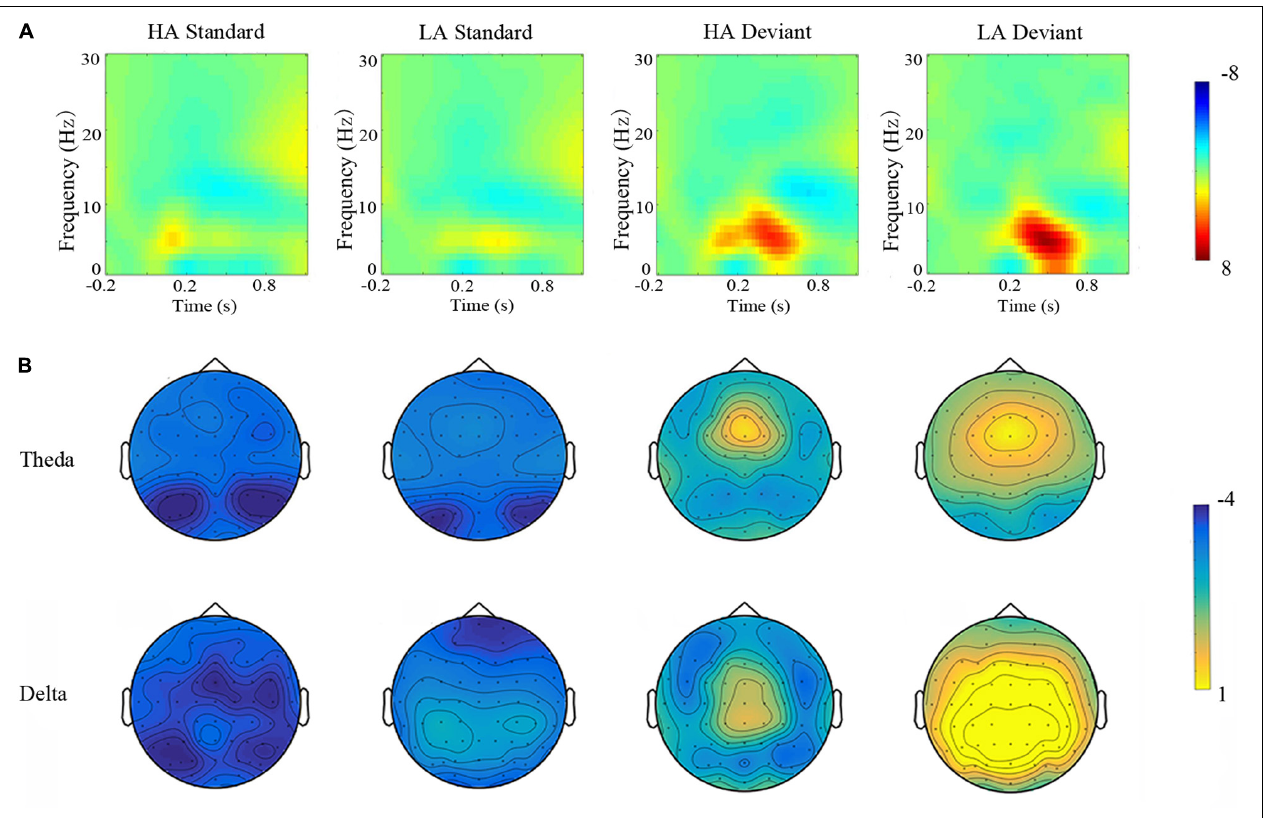
FIGURE 4 | Top panel (A) time-frequency. The grand averaged short-time Fourier transform absolute power of delta (0.1–3 Hz) and theta (4–8 Hz) subcomponents in response to standard and deviant conditions for residents of LA and HA regions. Bottom panel (B) topographic maps. Scalp distributions of theta and delta band powers elicited by the standard and deviant conditions for LA and HA amplitude residents.